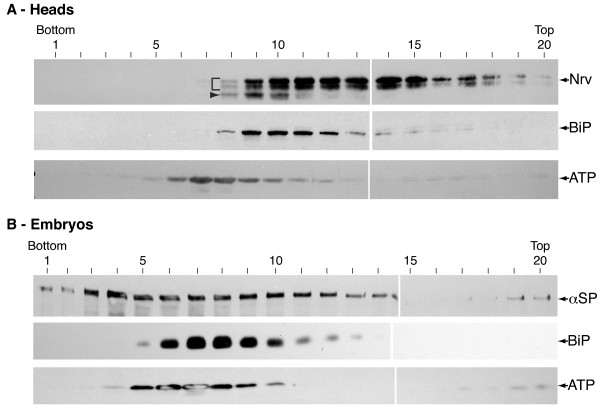
Immunoblot analysis of samples fractionated on 10-30% Optiprep density gradients. A - Fractionation of microsomes prepared from heads. BiP, marking the ER, peaks in the center of the gradient in fractions 9-11. ATP synthase shows that residual mitochondrial membrane is slightly heavier than the ER with a peak in fraction 7, but also shows a small presence in higher fractions at the top of the gradient. Nervana is seen as three prominent bands. The lowest (arrowhead) represents minimally processed protein and is restricted to the ER. The mature glycosylated forms (bracket) represent post-Golgi compartments and the plasma membrane. See [28] for a description of Nervana glycosylation patterns. B - Fractionation of microsomes prepared from 0-15 hr embryos. BiP, marking the ER, peaks slightly lower than the ER from head gradients in fractions 7-9. ATP synthase again peaks in fraction 7, and again has a small presence in higher fractions at the top of the gradient. α-Spectrin has a peak in the Golgi region (fractions 3-4), extends through the ER and shows a distinct peak at the top of the gradient. Labeling: 1-20 - fraction number from bottom to top of tube; all other labels are as in figure 2. Loading: An equal volume of all fractions were loaded, except the peak protein fractions (4-6) where 50 μg of protein was loaded to prevent overloading.